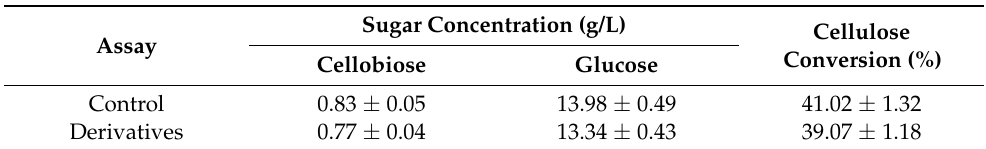
Conversion (%)Cellobiose Glucose